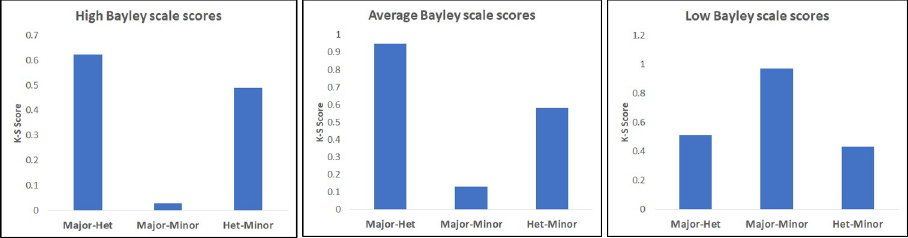
Fig 9. The Kolmogorov-Smirnov (K-S) test of similarity of distributions for the growth parameter phenotype ( linf ) genetically stratified according to PAK6 genotype (similarly to Fig 7). The K-S test is shown for different values of Bayley scale phenotype (Composite language score at 24 months).